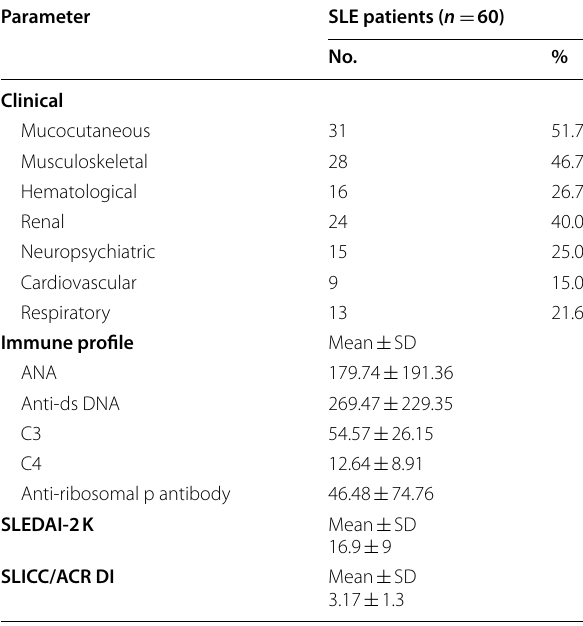
Table 1 Sociodemographic data of SLE patients and the control group